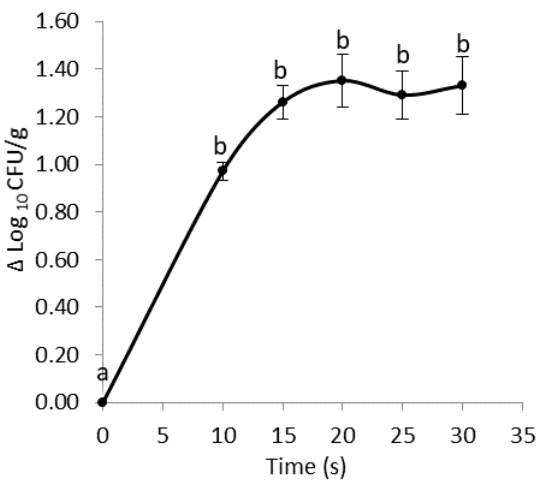
Figure 3. Logarithmic reduction of the total microbial count of fresh lettuce leaves after air atmospheric pressure plasma jet (APPJ) treatment in function of the treatment time (mean values ± standard error; CFU = colony forming unit). Different letters indicate statistically significant differences between time points, according to the analysis of variance (ANOVA) followed by Sidak post-hoc test ( p < 0.05; n = 3).